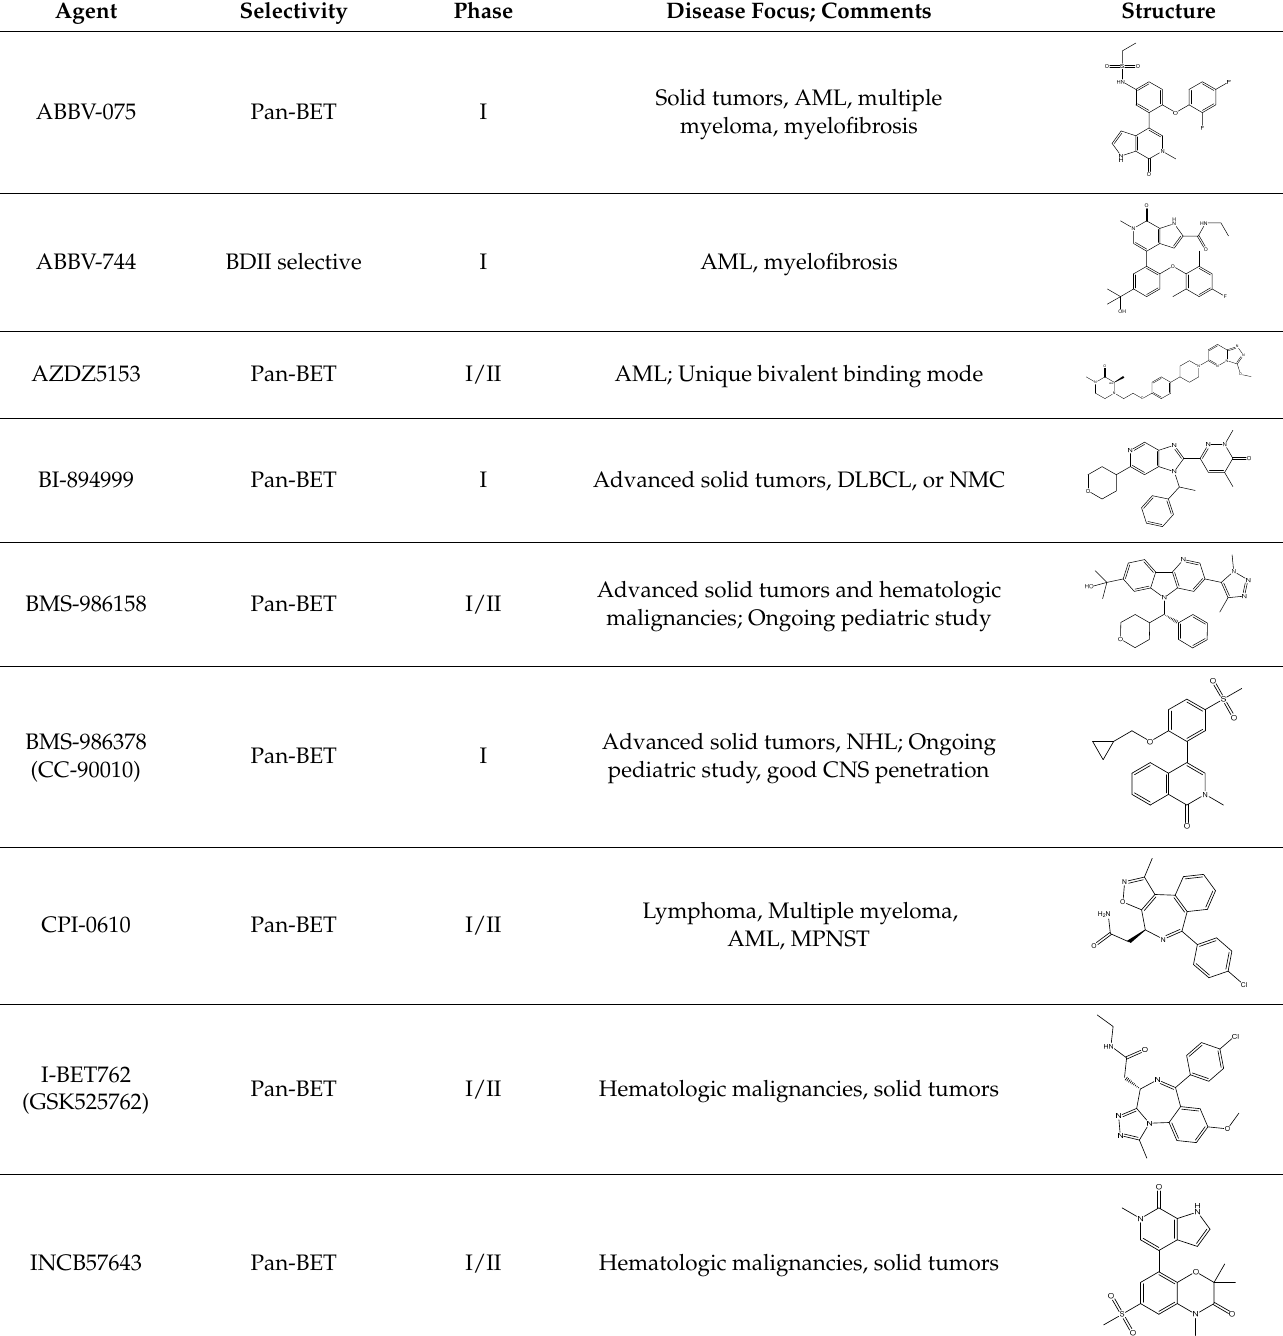
Table 1. BET inhibitors in clinical development. Agent